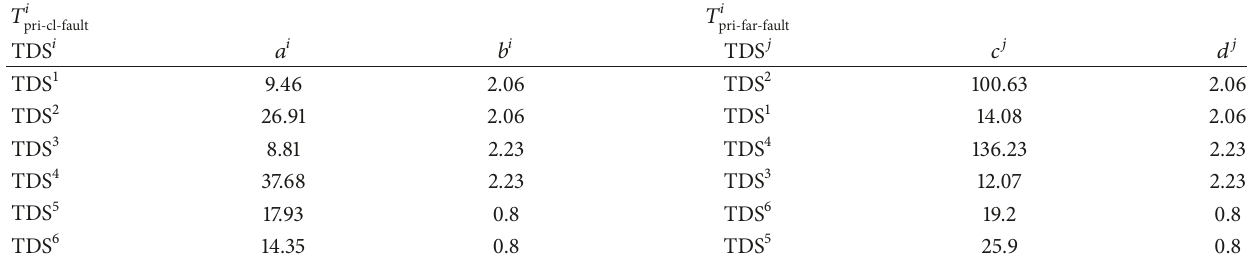
Table 7: Values of constants 𝑎 𝑖 , 𝑏 𝑖 , 𝑐 𝑖 , and 𝑑 𝑖 for Model 1.